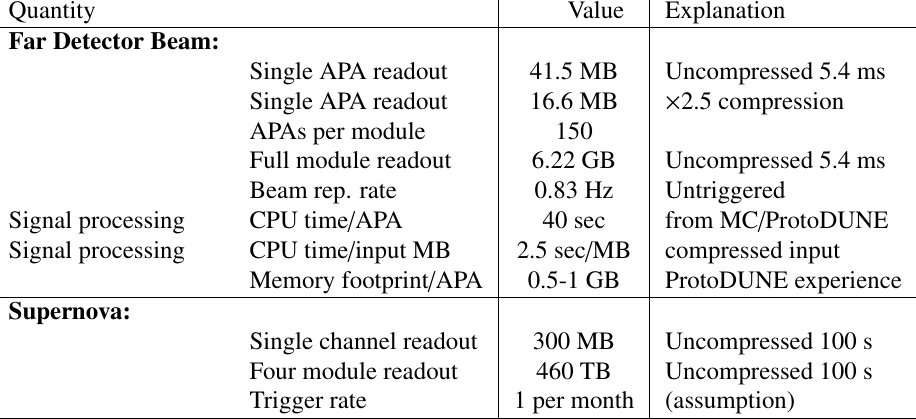
Table 2. Useful quantities for computing estimates for single-phase (SP) readout. For sparse FD events, the pattern recognition phase, which scales with occupancy is expected to be substantially faster than the signal processing phase which scales with detector